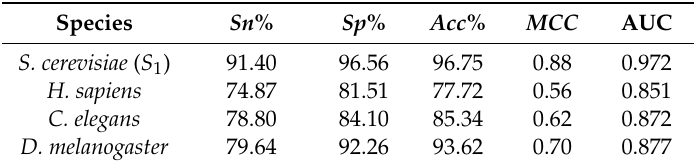
Table 2. Prediction results of 10-fold cross-validation for four species by ZCMM